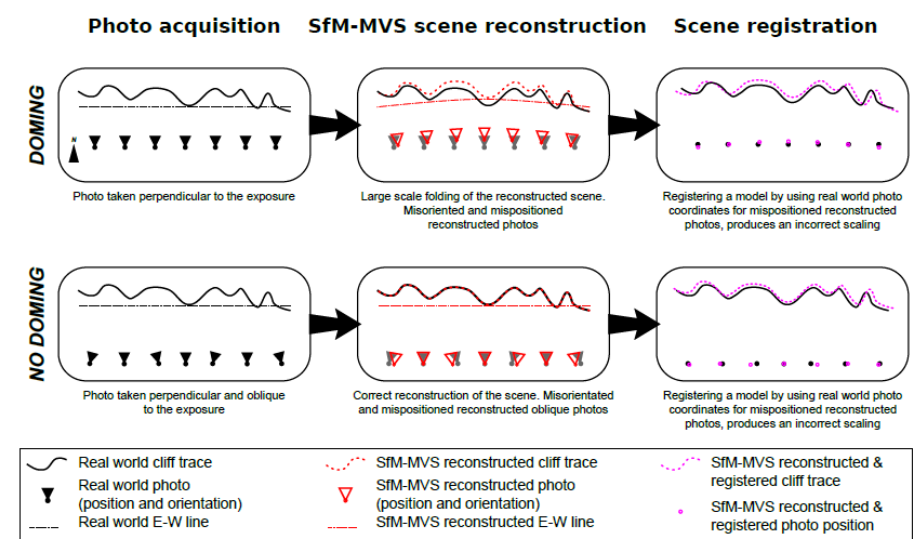
Figure 1. Scheme showing in map view the effect of lens distortion on scene registration. Models using only photographs oriented perpendicular to the reconstructed landscape are affected by doming of the scene, which leads to erroneous estimates of camera position during structure from motion-multiview stereo (SfM-MVS) reconstruction. Models using oblique photos are not affected by doming, but the reconstructed orientation and position of photos oblique to the scene exhibit large errors. In both cases, utilizing XYZ coordinates for an image that has been misaligned during SfM-MVS reconstruction stretches the scene and produces major scaling errors.